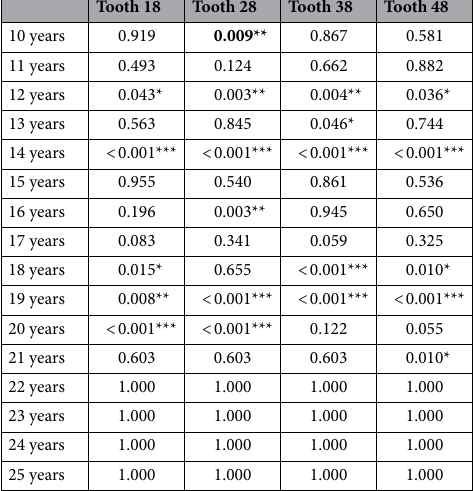
Table 4. Grade of maturation in men and women, according to Demirjian method. *p < 0.05; **p < 0.01; ***p < 0.001.